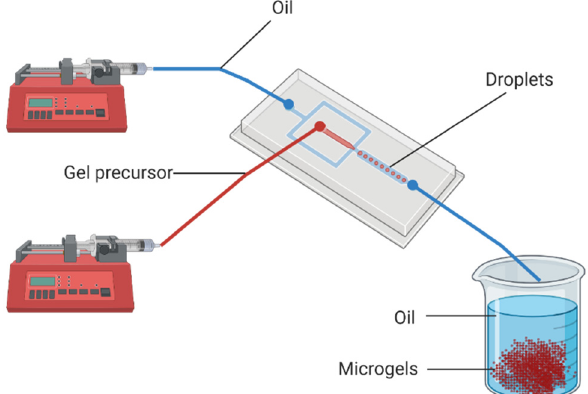
Figure 1. Microfluidic emulsion set up. The two immiscible fluids (water and oil) are pumped out of the syringes into the microfluidic chip. The relative flowrates of the two fluids, as well as the geometry of the microfluidic chip, dictate the size of the droplets generated in the chip. The droplets transform into microgels, which are then collected and washed to remove excess oil.